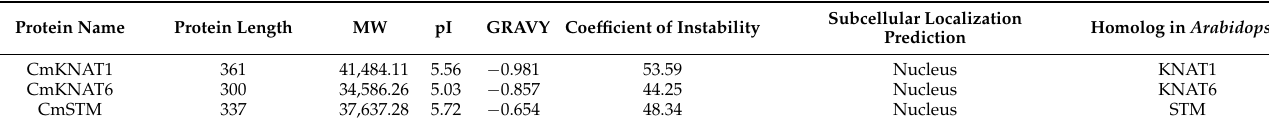
Table 1. Sequence analysis of three KNOX proteins in chrysanthemum.